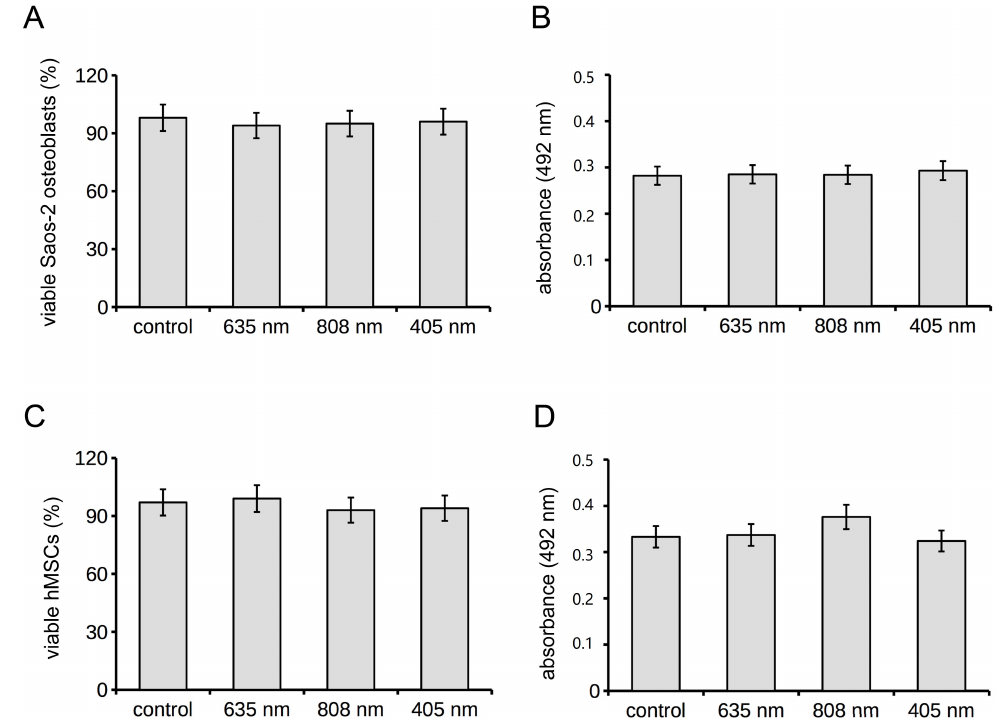
Figure 1. Effects of red (635 nm), NIR (808 nm) and violet-blue (405 nm) PBM on osteoblast and hMSC viability. Osteoblasts and hMSCs subjected or not (control) to PBM treatments with 635 nm, 808 nm or 405 nm as reported in Table 1, were cultured for 24 h in their specific PM and then assessed for cell viability. ( A , C ) PI/Syto16 test. Histograms show the morphometric analysis of percentage of Syto16 positive viable ( A ) osteoblasts and ( C ) hMSCs. ( B , D ) MTS assay. Absorbance (492 nm) of soluble formazan resulting from the reduction of tetrazolium by mitochondrial enzymes of viable ( B ) osteoblasts and ( D ) hMSCs, measured using a multi-well scanning spectrophotometer. Confocal immunofluorescence examination for the expression of the nuclear proliferation marker Ki67 showed no significant differences in the percentage of cells positive for this marker at 24 h post phototreatments with 635 nm or 405 nm as compared to control cells (Figure 2A,B,D,E). By contrast, the proliferative ability of osteoblasts appeared significantly reduced 24 h after PBM with 808 nm (Figure 2C,E). Consistent with these results, 808 nm induced a prominent cytoskeletal rearrangement, with the formation of massive well-defined F-actin filaments possibly stress fibers (Figure 2C) and an increased expression of the focal adhesion protein vinculin aggregated in large clusters at the end of the filaments, a feature typical of substrate-adherent cells (Figure 2C,F) as compared to controls (Figure 2A,F) in which thin F-actin filaments appeared arranged in a web-like structure or in parallel arrays whereas vinculin accumulated in small dot-like aggregates at either the cell border and scattered throughout the cytoplasm . Of note, cells irradiated with 635 nm displayed an actin cytoskeleton assembly comparable to that of control cells but, differently from controls, they displayed an increase of vinculin-rich focal adhesion sites predominantly at the periphery of the cells (Figure 2A,B,F). Cytoskeleton assembly as well as vinculin expression, localization and distribution pattern in osteoblasts exposed to 405 nm were comparable to those of control cells (Figure 2A,D,F).